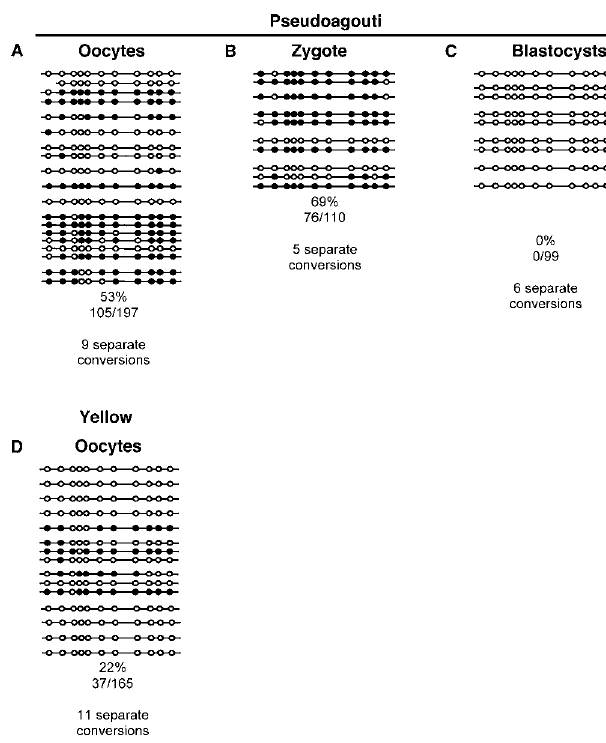
Figure 4. Methylation of the A vy Allele following Maternal Transmission The methylation status of each CpG dinucleotide was determined by sequencing PCR clones of bisulfite-converted DNA, as described in Figure 2 [4]. Each block of lines represents the clones derived from one bisulfite conversion of ten cells (oocytes or zygotes). The percentage of methylation in each dataset is shown (calculated from the number of methylated CpGs divided by the total CpGs sequenced, multiplied by 100). Clones were only included in the samples if they could be distinguished from others in the sample by CpG or non-CpG methylation. Any clones with higher than 5% non-CpG methylation (an indication of incomplete bisulfite conversion) were excluded from the dataset, and these clones made up less than 5% of all clones sequenced. (A) and (D) Unfertilised oocytes from pseudoagouti or yellow A vy /a females, respectively. DNA methylation at the A vy allele does not appear to have been reset during oogenesis. (B) Zygotes from pseudoagouti A vy /a dams mated to a/a sires. (C) Blastocysts from pseudoagouti A vy /a dams mated to a/a sires. The A vy allele is not subject to rapid demethylation immediately postfertilisation following maternal inheritance, but is completely cleared of DNA methylation before blastocyst formation. DOI: